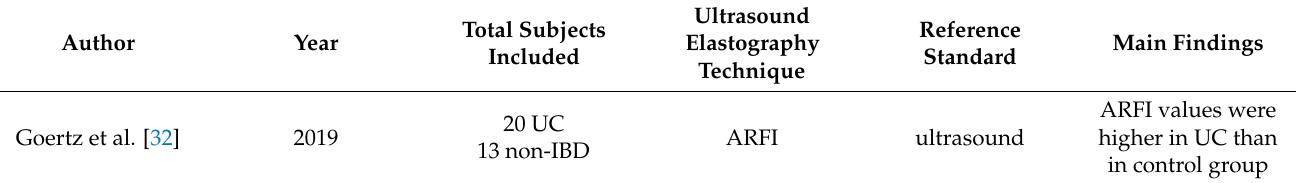
Table 2. Ultrasound elastography of intestines in ulcerative